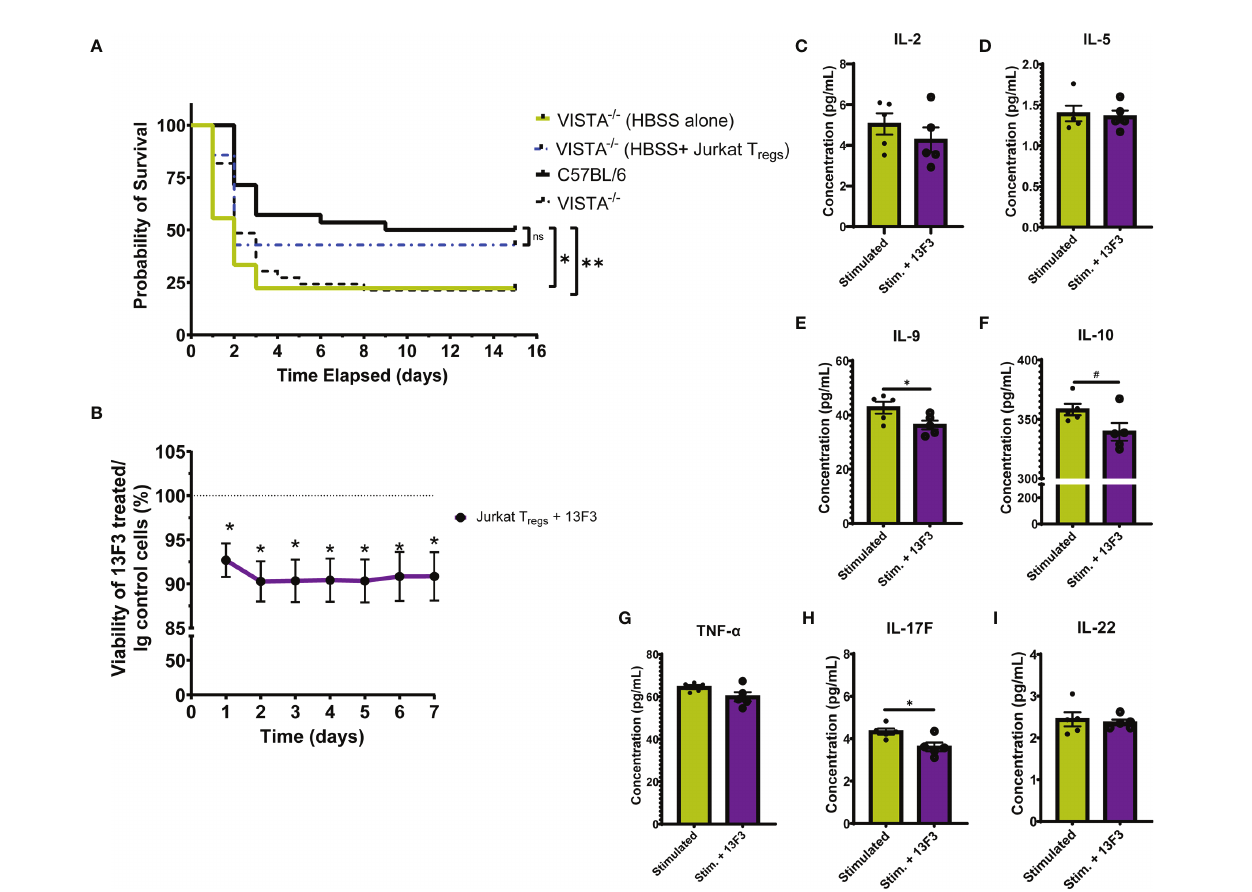
FIGURE 10 | Adoptive transfer of Jurkat T regs improves survival of VISTA -/- mice post CLP. Blockade of VISTA in Jurkat T regs in vitro reduces viability and cytokine production. (A) 14-day survival following adoptive transfer and CLP [VISTA -/- (HBSS alone): n = 11 , VISTA -/- (HBSS+ Jurkat T regs ): n = 10 ]. (B) Alamar Blue viability assay of Jurkat T regs following treatment with Ig control or 13F3. (C – I) Supernatant cytokine concentration of Jurkat T regs following treatment with plasma from septic mouse (stimulated) or plasma and 13F3 (stim. + 13F3). Summary graphs show mean ± SEM; not signi fi cant ns ; signi fi cance # p = 0.05; *p < 0.05; **p <